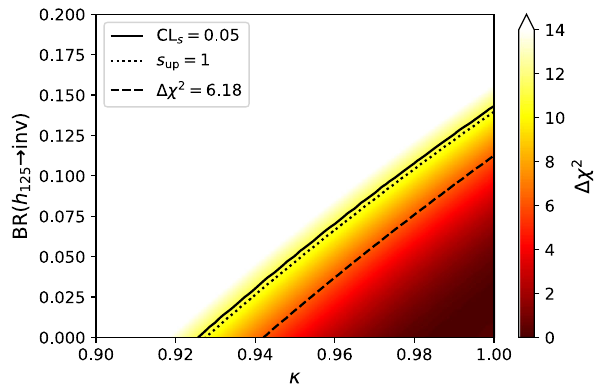
Fig. 5 The HiggsSignals (cid:9)χ 2 profile in a toy model with a global Higgs-coupling scale factor κ and an additional Higgs decay into invis- ible final states with decay rate BR ( h 125 → inv ) . The contour lines indicate the borders of the 95% C.L. allowed regions derived from a fit (dashed) and a limit setting procedure using CL s + b (dotted), which corresponds to s up = 1, and CL s